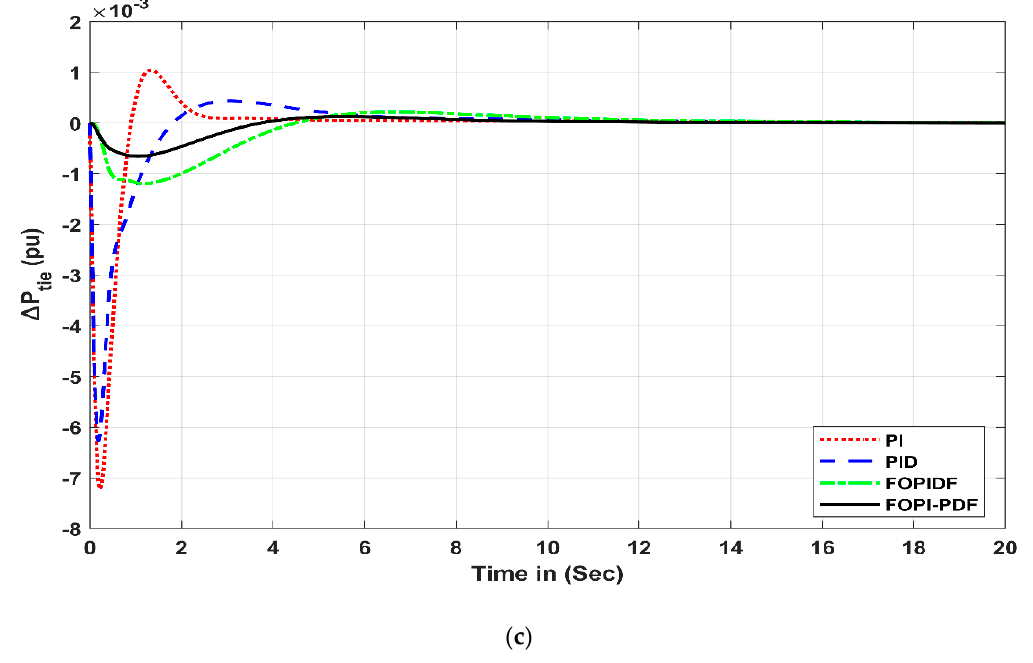
Figure 9. Dynamic response of the PS for Case-2 ( a ) ∆ F 1 ( b ) ∆ F 2 ( c ) ∆ P tie . Table 3. Transient results for hybrid PS considering Case-2.